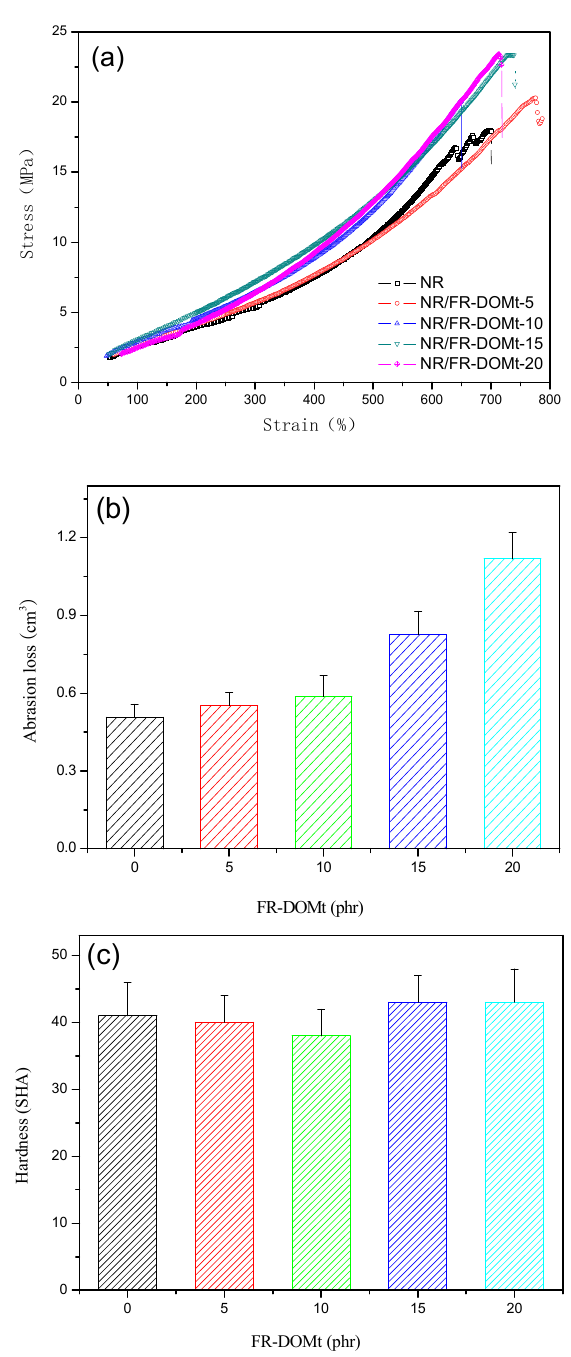
Figure 6. Mechanical properties of different NR nanocomposites ( a ) stress-strain curves, ( b ) abrasion loss, ( c ) hardness.